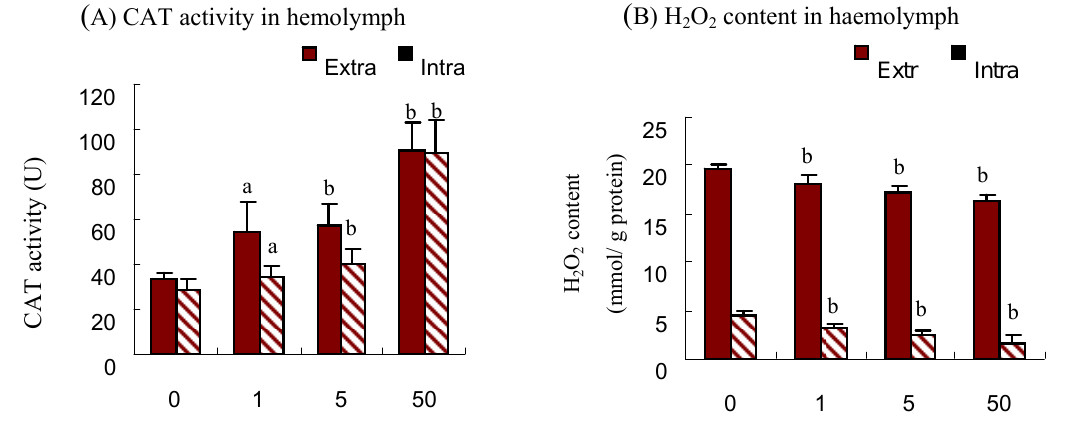
Figure 1. Extracellular and intracellular CAT activity and H exposed to different concentrations of L-ENK. (A) Extracellular and intracellular CAT activity of haemolymph exposed to different concentrations of L-ENK. (B) Extracellular and intracellular H O content of haemolymph exposed to different concentrations of L- 2 2 ENK. a P<0.05 compared with control group, b P<0.01 compared with control group. The error bars represent the